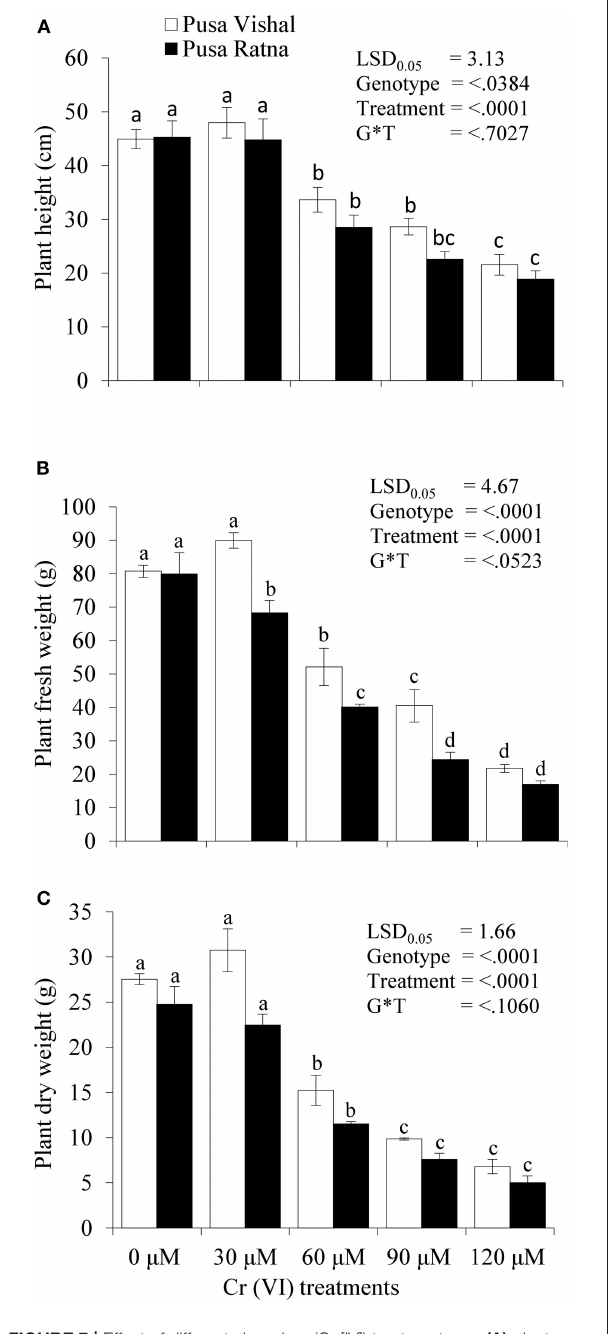
FIGURE 7 | Effect of different chromium (Cr [IV]) treatments on: (A) plant height (cm), (B) plant fresh weight (g), and (C) plant dry weight (g) of two Mungbean cultivars, Pusa Vishal (PV) and Pusa Ratna (PR) in pot conditions. Mean values of three replicates are shown; error bar ( ± standard error [SE]). Mean values with same letter don’t have significant difference at p ≤ 0.05 according to the Least Significant Difference test (LSD 0.05